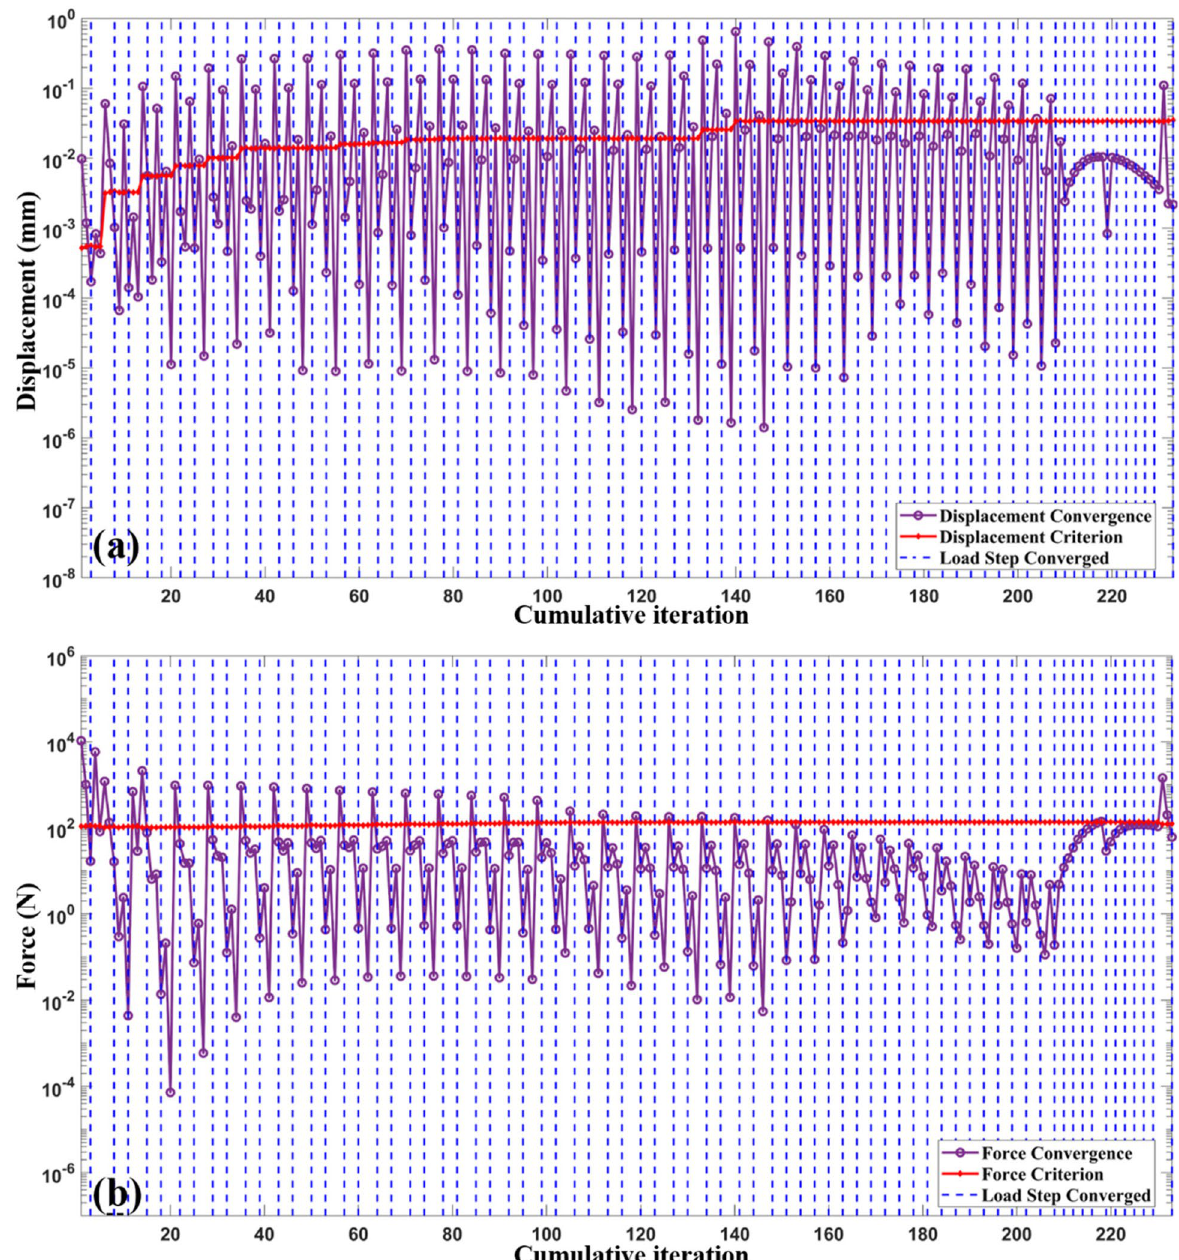
Fig. 12 a and b are displacement and force convergence curves of the FEA simulation process. The magenta lines denote the convergence outcomes of each cumulative iteration step. The red lines represent the criterion values. The blue vertical dotted lines indicate the converged load